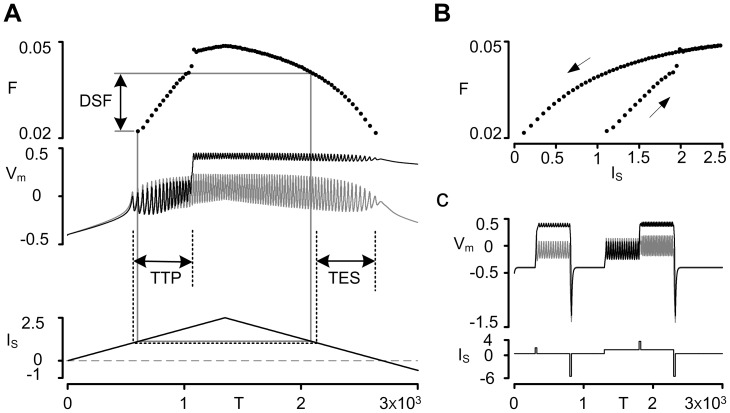
Bistable firing behaviour of the DC/AC-RM.(A). Time course of membrane potentials (middle panel: VS gray, VD black) during the triangular current stimulation to the soma (bottom) and their instantaneous frequencies (top). Three characteristic indexes for detecting the bistable firing of the model: Time To onset of Plateau potential (TTP), Time to End of somatic Spiking (TES) and Difference in Spiking Frequency (DSF). (B). The hysteretic relationship of the frequency responses to current stimuli for the case of (A). (C). Switching behaviour of membrane potentials (VS gray, VD black) under the briefly depolarizing and hyperpolarizing current stimulation protocol (bottom). V, I, F and T are dimensionless voltage, current, firing rate and time respectively.